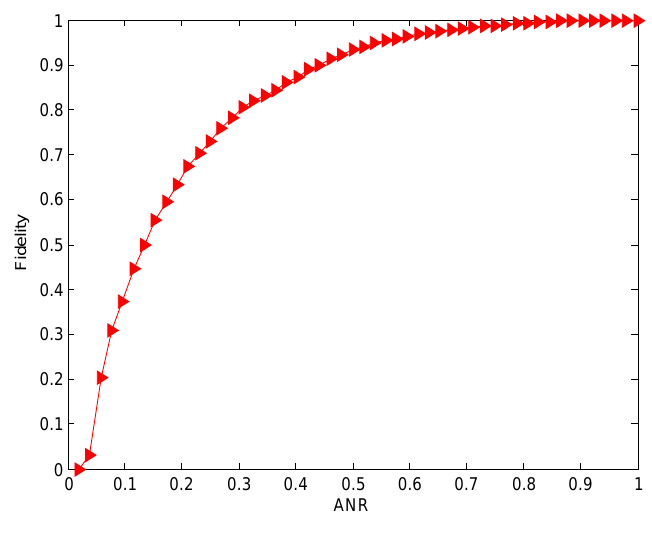
Figure 6. Structure fidelity vs . ANR. Table 1. Nodes contribution rate with different active node